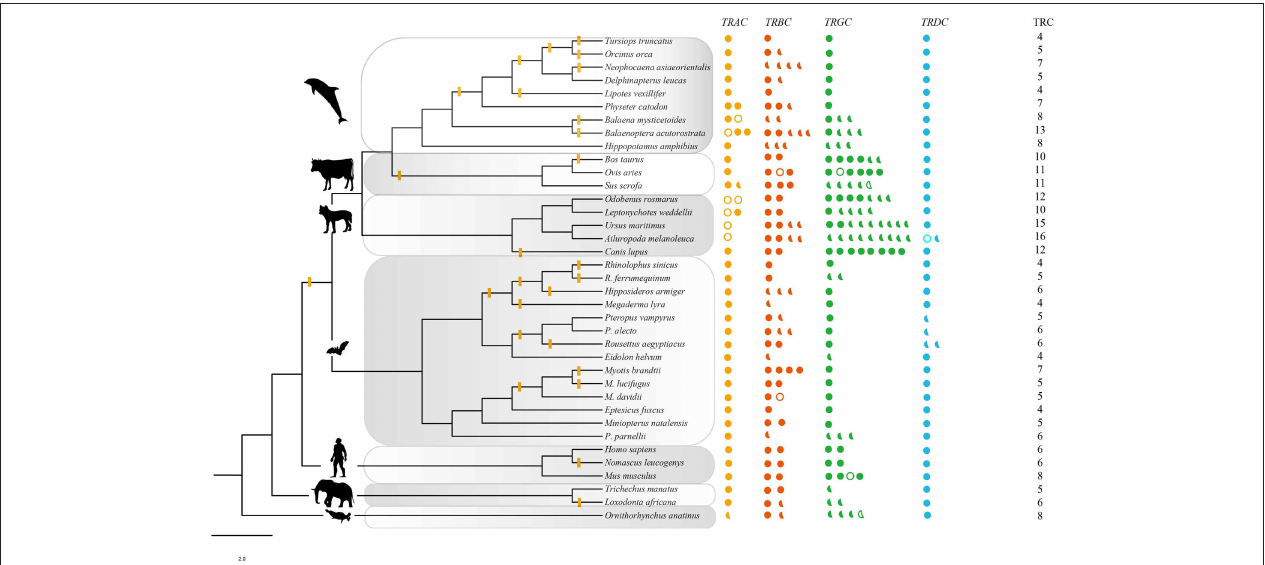
FIGURE 1 | TRC repertoires in 37 species. Solid circles: intact genes; solid semicircles: partial segments; hollow circles and (or) semicircles: pseudogenes. The phylogenetic tree was modified from a widely accepted phylogeny of mammals ( 32–34). The branches with yellow bars indicated the evidence of positive selection estimated by free ratio. The intensity of positive signal in each taxon was calculated following the equation: intensity = total signal/total number of examined branches and nodes. Artiodactyla: 2/5, carnivora: 2/9, euarchontoglires: 1/5, afrotheria: 1/3. Yellow: TRAC , red: TRBC , green; TRGC , blue: TRDC .